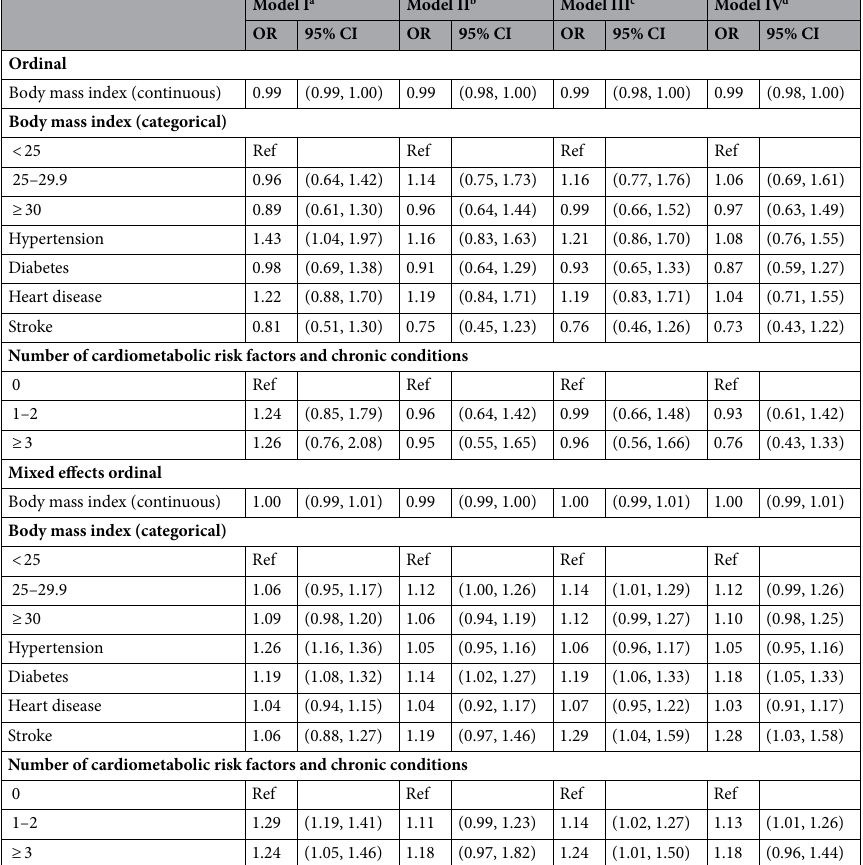
participants eliciting a ‘Medium’ level of Covid-19 concern, those with ‘High’ level of Covid-19 concern had significantly more Black/African Americans versus White/Caucasians (RRR = 2.70, 95% CI 1.59, 4.56), current smokers versus never smokers (RRR = 2.39, 95% CI 1.12, 5.14), individuals with fair or poor self-rated health versus excellent, very good or good self-rated health (RRR = 1.63, 95% CI 1.03, 2.58) and significantly fewer individuals who were high school versus no degree (RRR = 0.45, 95% CI 0.23, 0.86) or college graduates versus no degree (RRR = 0.23, 95% CI 0.12, 0.46), those with a total wealth ranging between $25,000 and $299,999 versus < $25,000 and those who consumed alcohol ≥ 3 days per week versus abstainers (RRR = 0.51, 95% CI 0.28, 0.92). There was significant positive association of ‘High’ versus ‘Medium’ level of Covid-19 concern with the depression symptoms score (RRR = 1.15, 95% CI 1.03, 1.29) as well as history of hypertension (RRR = 1.72, 95% CI 1.08, 2.73). Table 1 displays findings from a set of sequentially adjusted ordinal and mixed-effect ordinal logistic regres- sion models to examine obesity-related cardiometabolic risk factors and/or chronic conditions in relation to Covid-19 level of concern. Hypertension was associated with greater level of Covid-19 concern only in unadjusted models (OR = 1.43, 95% CI 1.04, 1.97 [ordinal logistic regression]; OR = 1.26, 95%CI 1.16, 1.36 [mixed-effects ordinal logistic regression]). Upon sequential adjustment for socio-demographic, lifestyle and health character- istics, these findings became statistically non-significant. By contrast, diabetes was associated with greater level of Covid-19 concern in the unadjusted (OR = 1.19, 95% CI 1.08, 1.32) and fully-adjusted (OR = 1.18, 95% CI 1.05, 1.33) mixed-effects logistic regression models. In fully-adjusted mixed effects ordinal logistic regression models, a history of stroke (OR = 1.28, 95% CI 1.03, 1.58) and having ‘1–2’ versus ‘0’ cardio-metabolic risk factors and/or chronic conditions (OR = 1.13, 95% CI 1.01, 1.26) were significantly associated with level of Covid-19 concern. Table 2 shows ordinal logistic and mixed-effects ordinal logistic regression models whereby key socio-demo- graphic, lifestyle and health characteristics identified in the bivariate analysis at α = 0.20 were entered into fully- adjusted models for Covid-19 level of concern. Female sex, older age, minority race (Black/African American versus White/Caucasian, Other versus White/Caucasian), ethnicity (Hispanic versus Non-Hispanic), total wealth